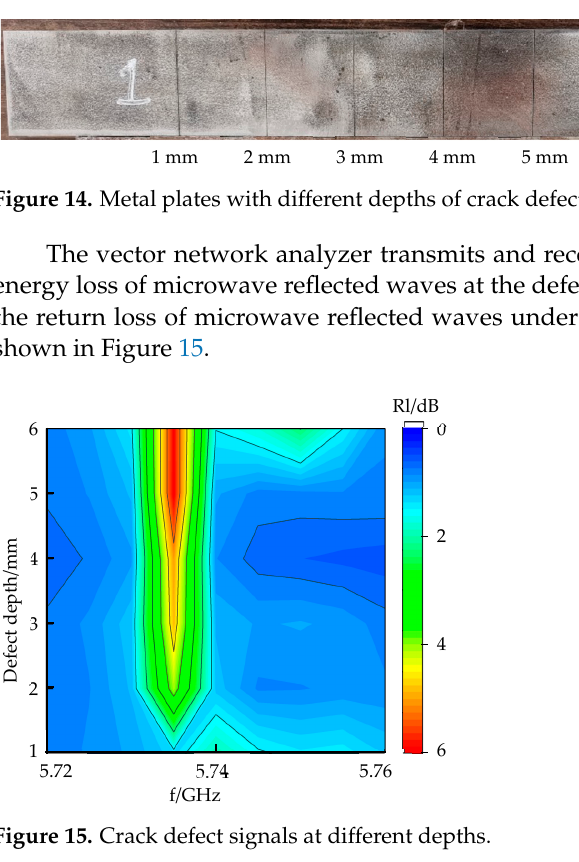
Figure 13. Schematic diagram of metal surface defect detection experiment.